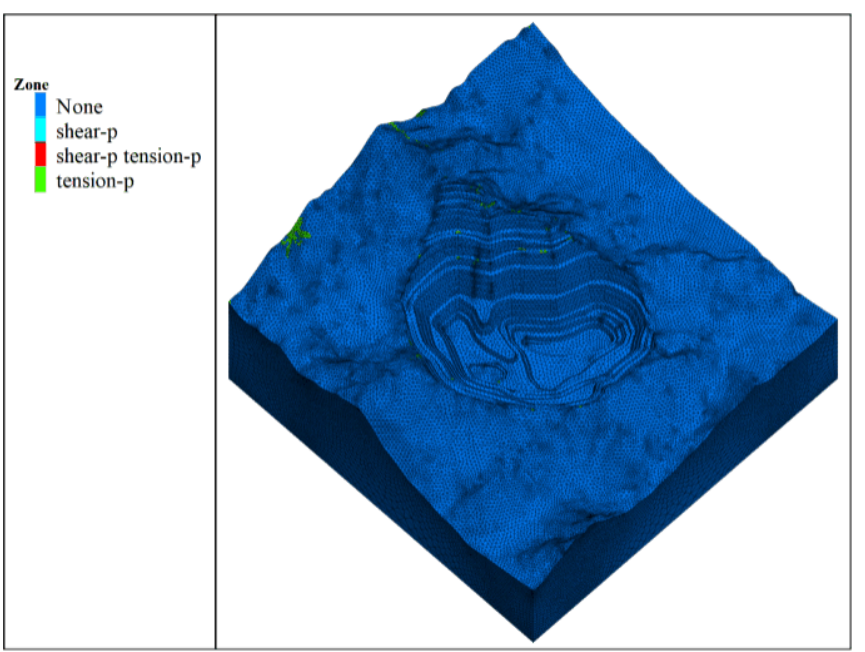
Figure 7. The principal stress diagram of the overall model: ( a ) minimum principal stress diagram; ( b ) maximum principal stress diagram.